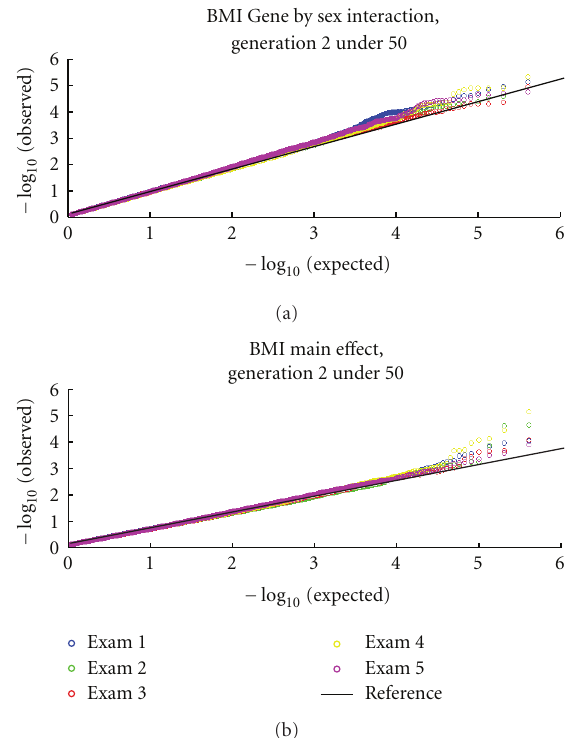
Figure 1: QQ plots for gene by sex interaction (a) and main e ff ect (b) GWAS for body mass index (BMI) in Generation 2, exams 1, 2, 3, 4, and